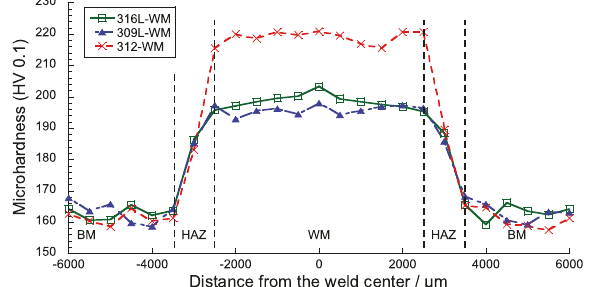
Fig. 4 Microhardness. Microhardness pro fi le showing hardness for BM, HAZ, and WM of the different weldments. The connecting lines are only guidance for the eye. The vertical dashed lines mark the edges of the HAZ.